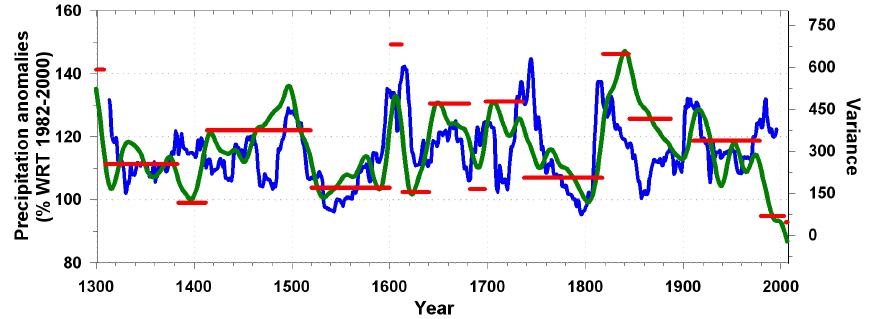
Fig. 8. Comparison between periods of reduced vs. abundant precipitation and interannual variability in the Altiplano precipitation recon- struction. Significant (95%c.l.) regime shifts (red line) detected by the Rodionov (2004) method (window length = 25yr), smooth spline (35yr) of the precipitation reconstruction (green line) shown in Fig. 3, and changes in variance ( × 10) calculated for 25-yr intervals plotted on the centroid + 1 for each interval (blue